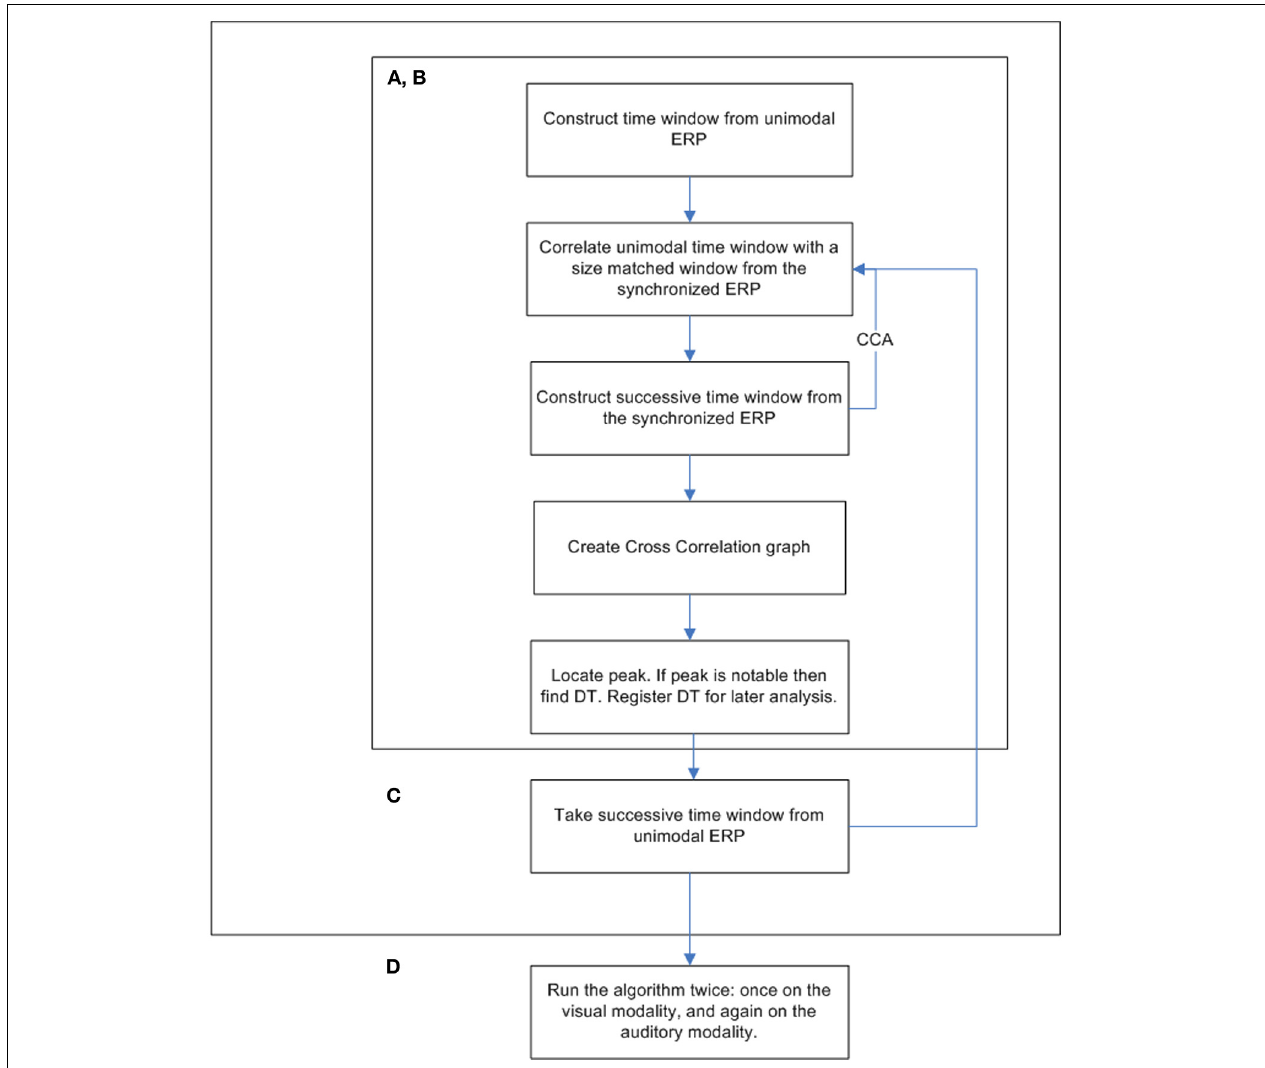
FIGURE 3 | The cross-correlation algorithm flow